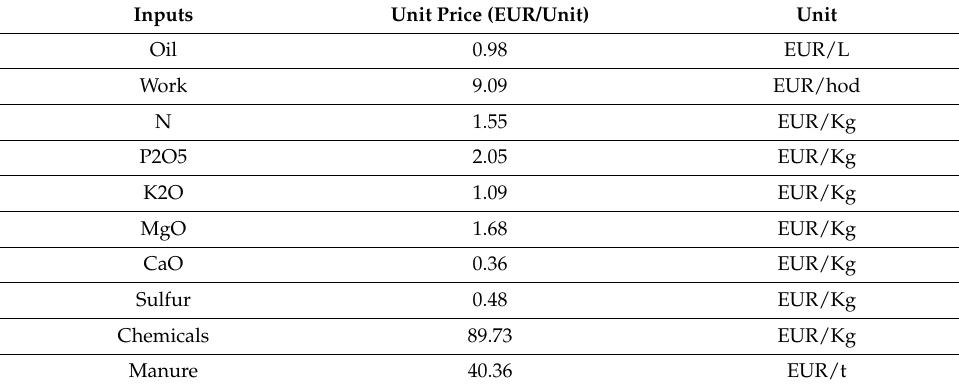
Table A4. Used unit costs of